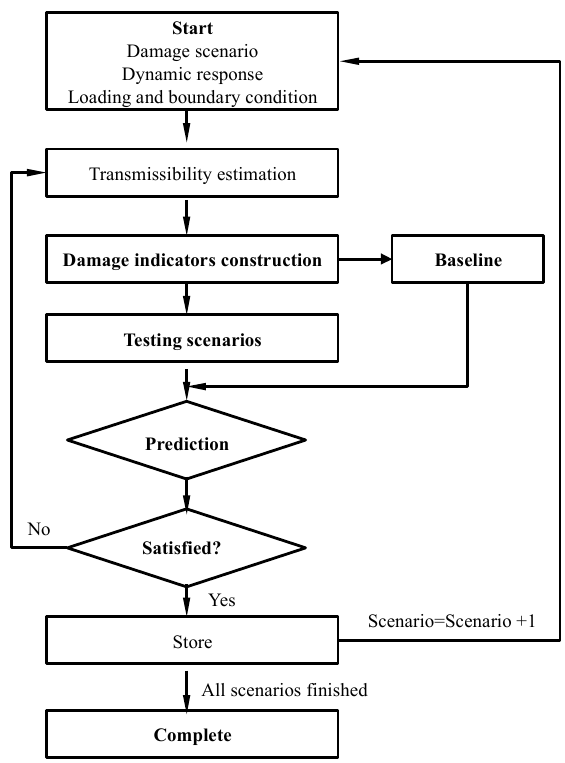
Figure 1. Flowchart of the transmissibility-based damage detection procedure.